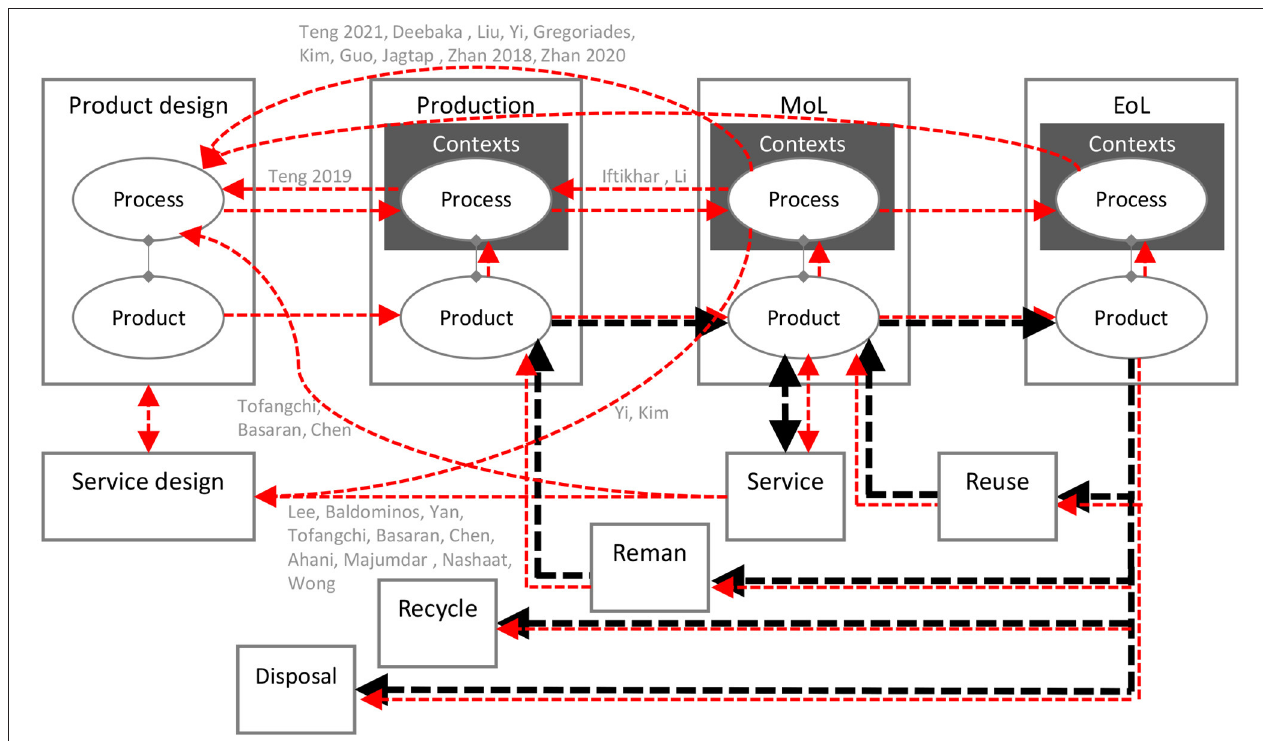
FIGURE 1 | Applications of BDA in industry mapped on PLM information flows. Note: Red (thinner) and black (thicker) arrows denote information and physical flows, respectively. BDA applications in Tables A1 , A2 are referred to by their first author names and, if needed, publication years. The PLM flows are developed based on (Kiritsis, 2011). MoL and EoL denote the middle of life and the end of life,